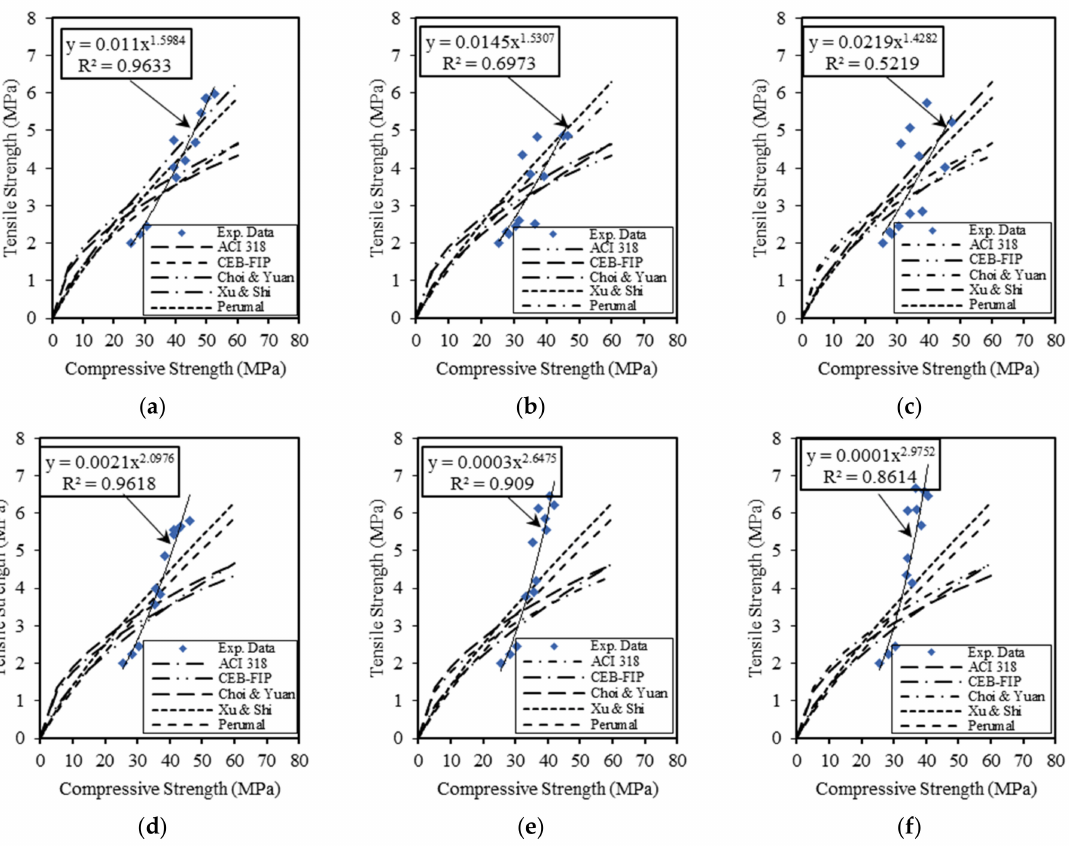
Figure 10. Relation between the compressive strength and splitting tensile strength of ( a ) MSF-13, ( b ) HSF-35, ( c ) HSF-60, ( d ) SYF-19. ( e ) SYF-38, and ( f ) SYF-54. Table 10. Summary of compressive strength and tensile strength